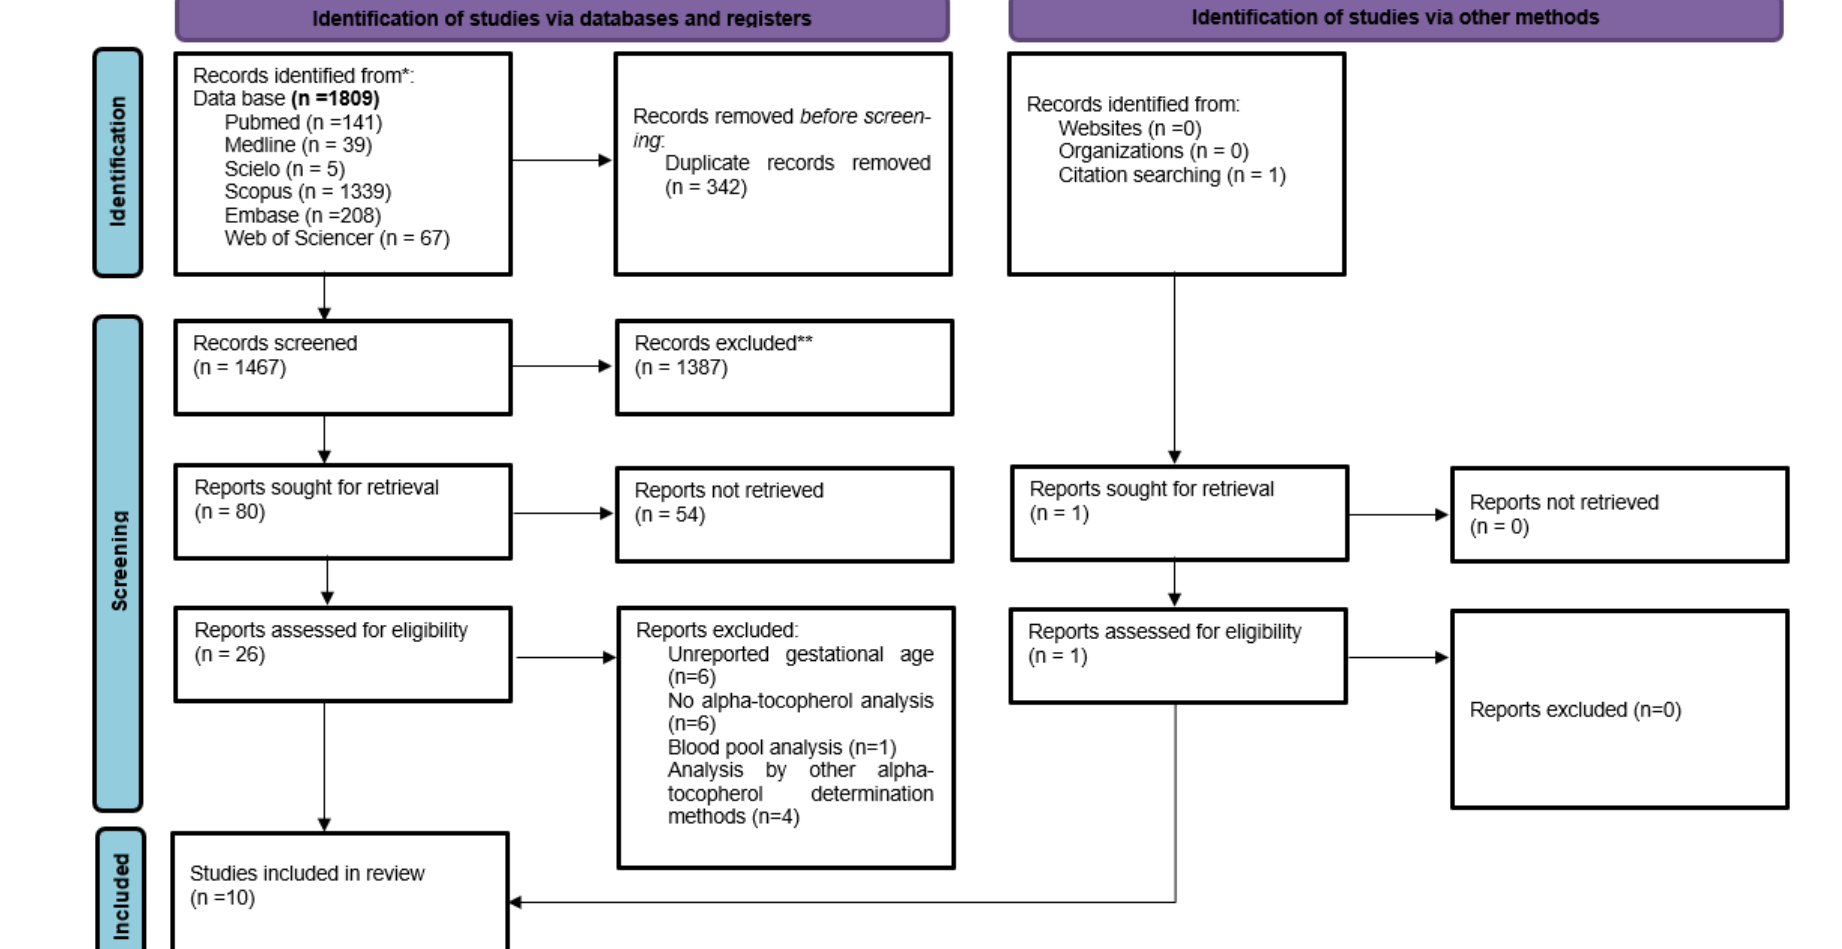
Figure 1. PRISMA flow diagram.